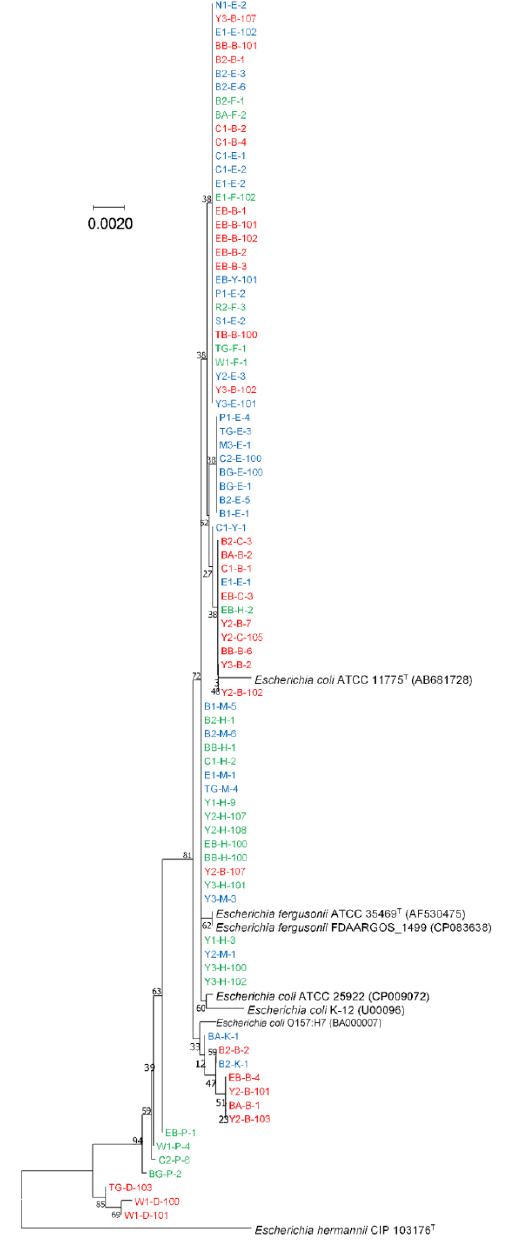
Figure 2. The neighbour-joining phylogenetic tree based on 16S rRNA gene sequences of isolated E. coli / E. fergusonii strains from patients with IBD or IC. The numbers at the nodes indicate the percentage of 1000 bootstrap replicates. Escherichia hermannii CIP 103176T was used an outgroup. The accession numbers of retrieved 16S rRNA gene sequences are given in parentheses. Strain names in red and blue represent IBD (red = CD; and blue = UC), and green represents IC.